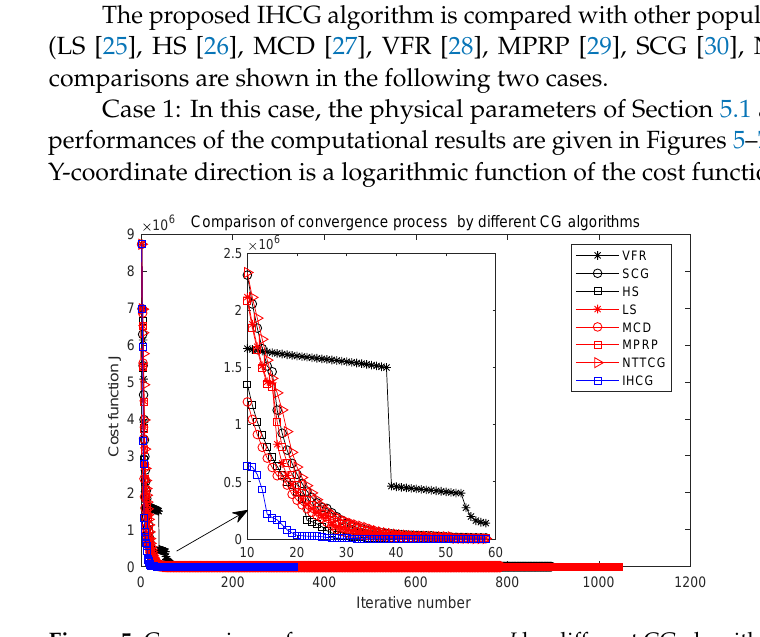
Figure 5. Comparison of convergence process J by different CG algorithms.